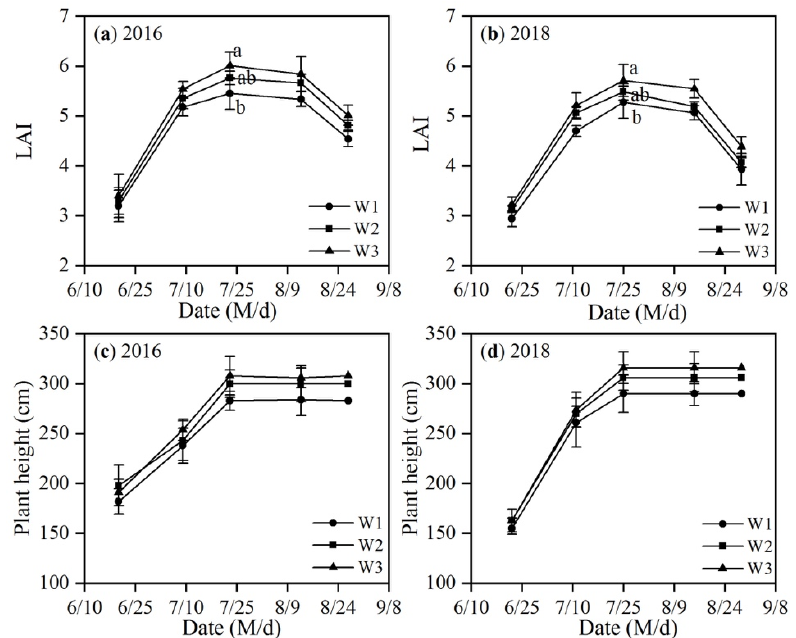
Figure 4. Temporal changes in leaf area index (LAI) ( a , b ) and plant height ( c , d ) due to W1, W2 and W3 ( a , c ) in 2016 and ( b , d ) in 2018. W1, W2 and W3 are the treatments with different D h (designed wetting depth). D h values in W1, W2 and W3 are 0–40 cm, 0–50 cm and 0–60 cm, respectively. Vertical bars represent standard errors. Different letters above bar plot indicate that there are significant differences in maximum LAI among treatments ( P < 0.05).